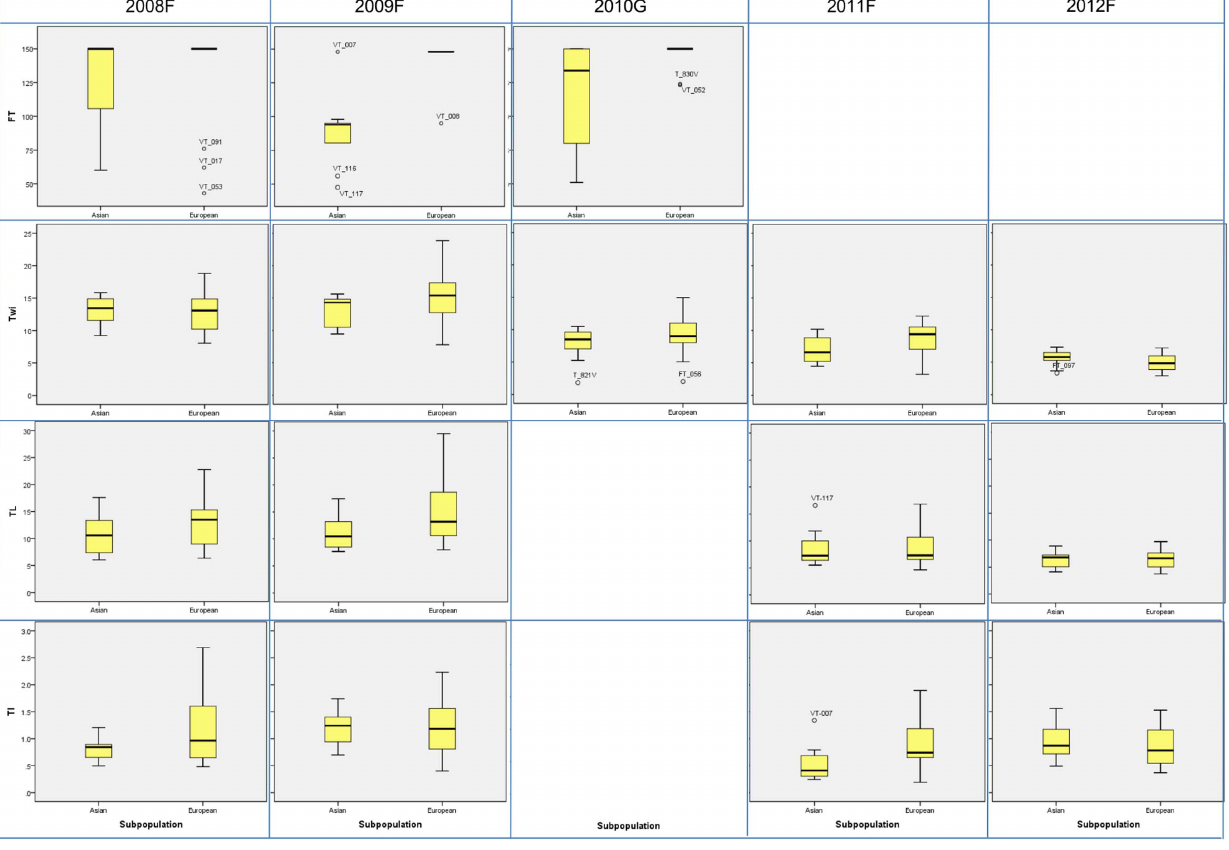
Figure 4. Boxplots for visualizing the comparison between Asian and European subpopulations, for the traits flowering time (FT), turnip width (Twi), turnip length (TL) and turnip index (TI) evaluated in five independent experiments. 2010G was carried out in the greenhouse in 2010 while other experiments were carried out in the open field between 2008 and 2012. Experimental set up and conditions are provided in Table S2 and Figure